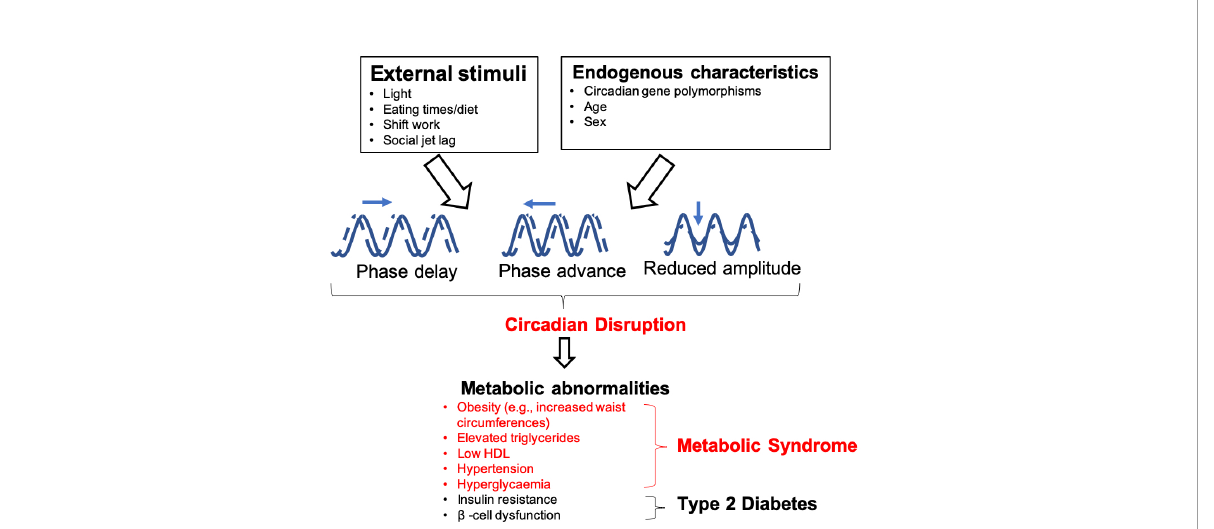
FIGURE 1 In fl uences on, and consequences of, circadian rhythm disruption. Both endogenous and external factors can predispose individuals to circadian disruption. This can cause dysfunction of peripheral oscillators, which are involved in the regulation of metabolic functions such as body weight homeostasis, glucose metabolism and b -cell function. Individuals who experience circadian disruption, which may be through phase delays/ advances or by changes in amplitude (difference between peak and trough of the rhythms) are at an elevated risk of developing metabolic abnormalities, which can lead to metabolic syndrome and